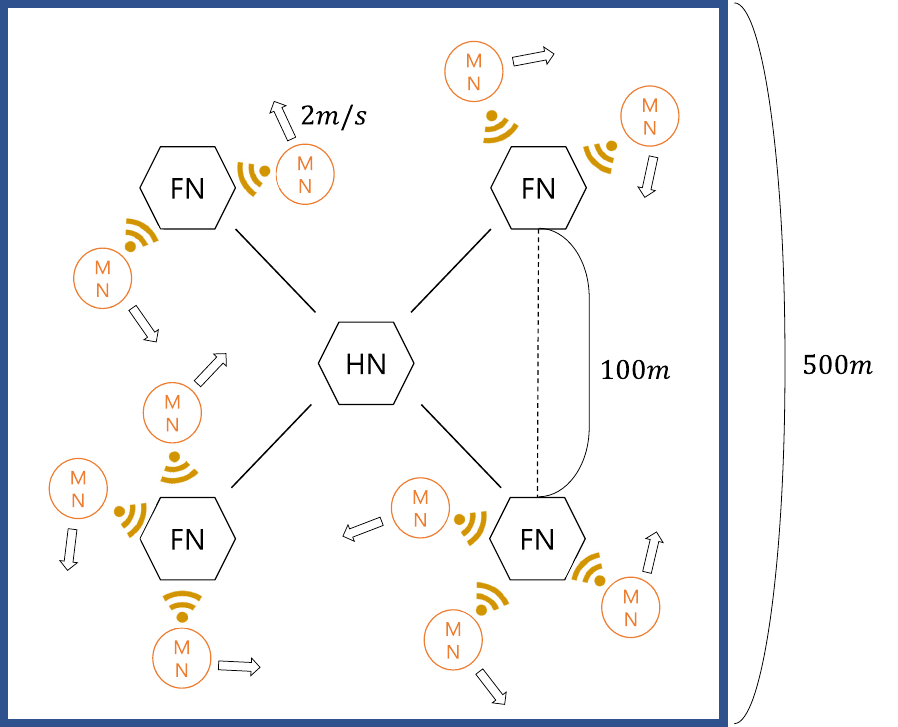
Fig 24. Topology of our simulation environment (when there are 10 mobile